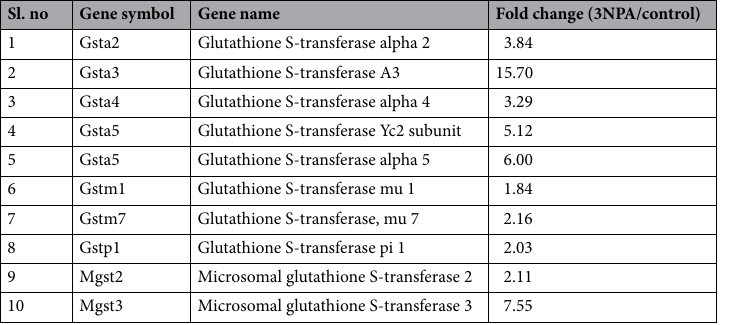
Table 1. List of various subunits and isoforms of glutathione-s-transferase (GST) upregulated in 3-NPA treated N27 cells. The gene symbol and gene name of different GST subunits/isoforms along with the fold change in expression (vs. control) noted in the transcriptomics experiment are